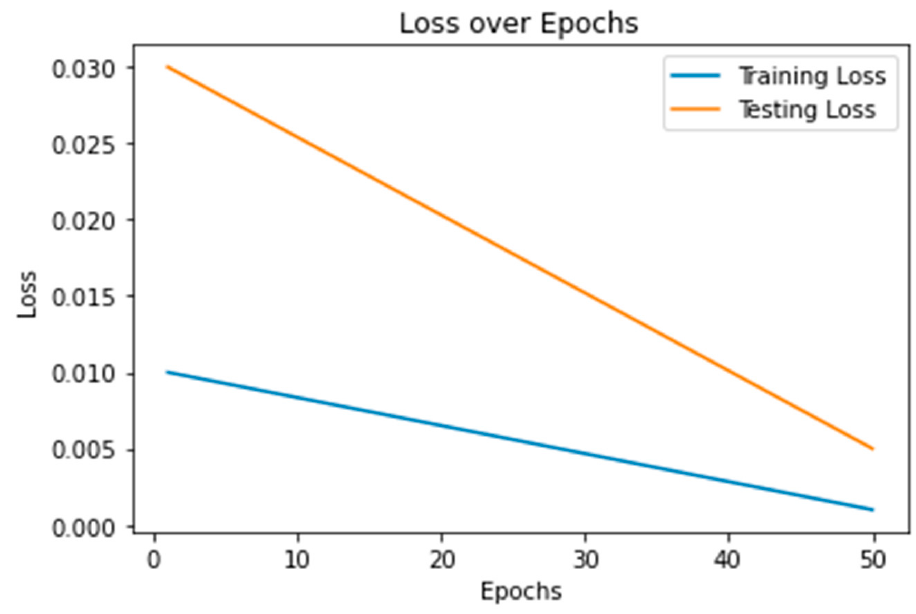
Figure 14. Training and testing loss for simple 3D U-Net classifier.